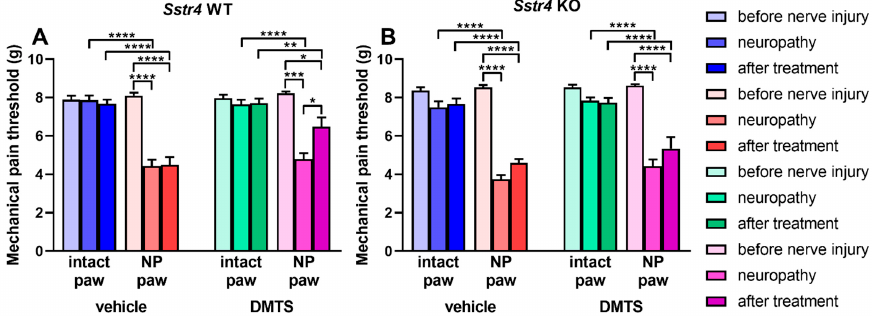
Figure 3. DMTS reduces mechanical hyperalgesia in the hind paws Sstr4 receptor WT animals. Mechanical pain threshold of the hind paws of Sstr4 WT ( A ) and KO ( B ) animals with unilateral sciatic nerve lesion before surgery, after neuropathy has developed and after vehicle or DMTS treatment. n = 6–7; one-way ANOVA followed by Tukey’s test; * p < 0.05, ** p < 0.01, *** p < 0.001, **** p < 0.0001 vs. indicated groups. NP: neuropathic side (right).